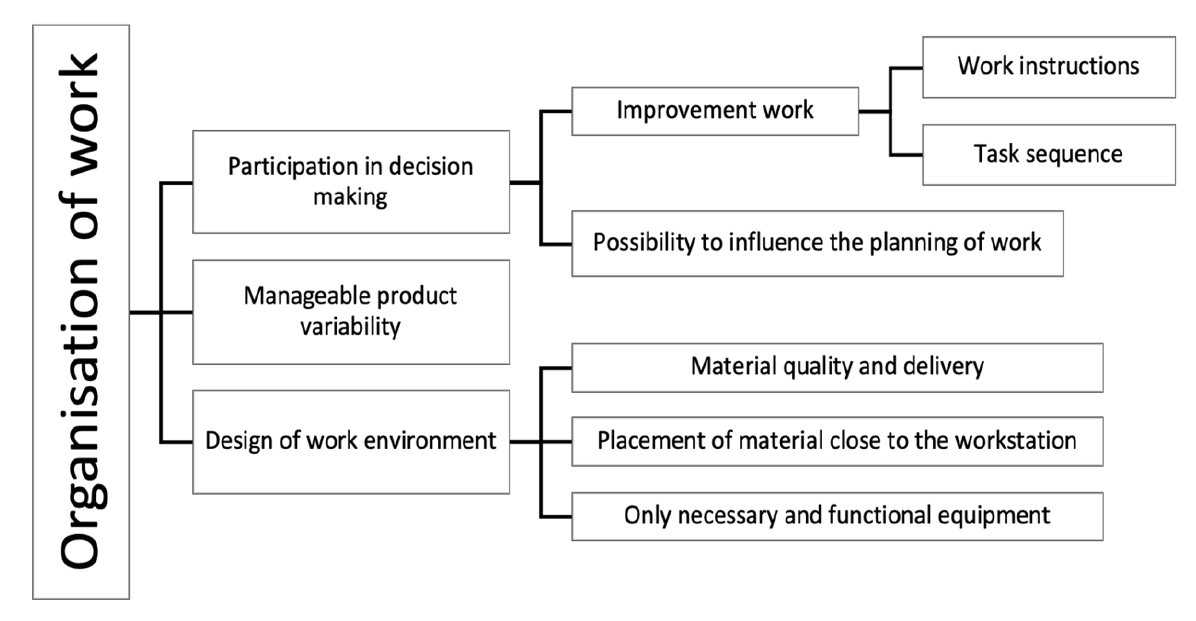
Figure 6. Resources regarding the organisation of work.